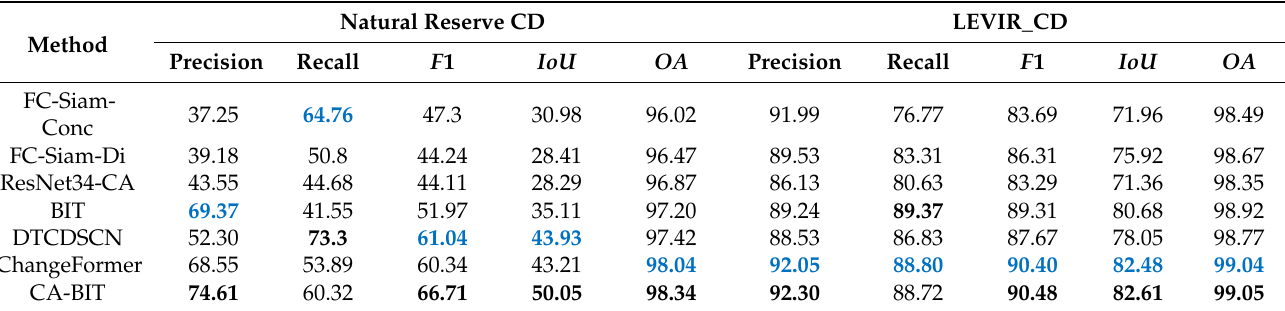
Table 1. Evaluation of CD accuracy under different methods.